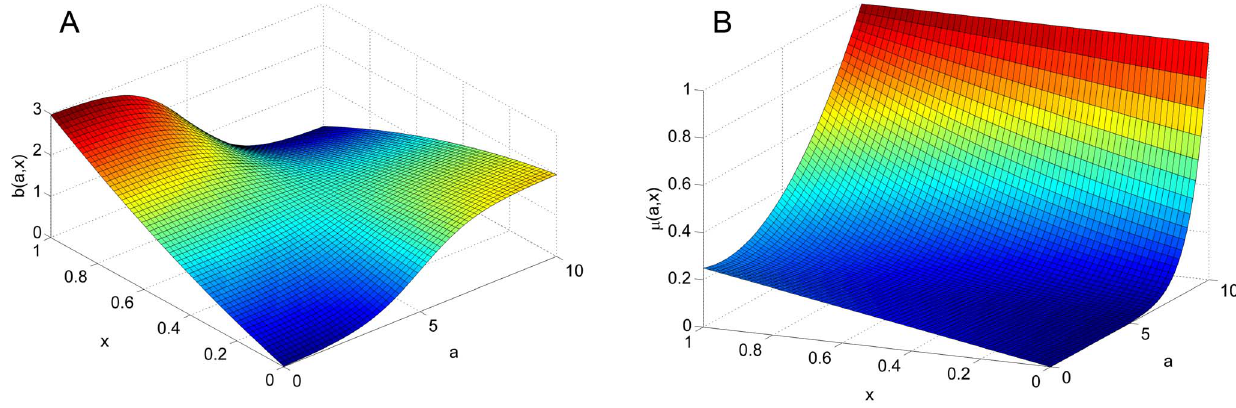
Figure 1. Birth and mortality functions. Panel A and B show b ( a , x ) and m ( a , x ) respectively. These two functions are defined such that they reflect the future versus current reproduction and growth/reproduction success versus mortality life-history